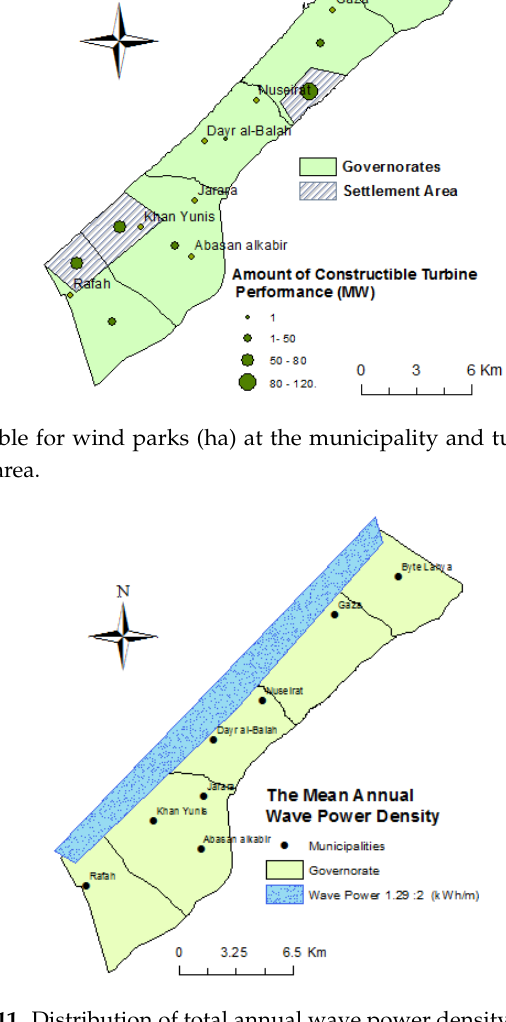
Figure 10. Area available for wind parks (ha) at the municipality and turbine performance (MW) corresponding to each area.